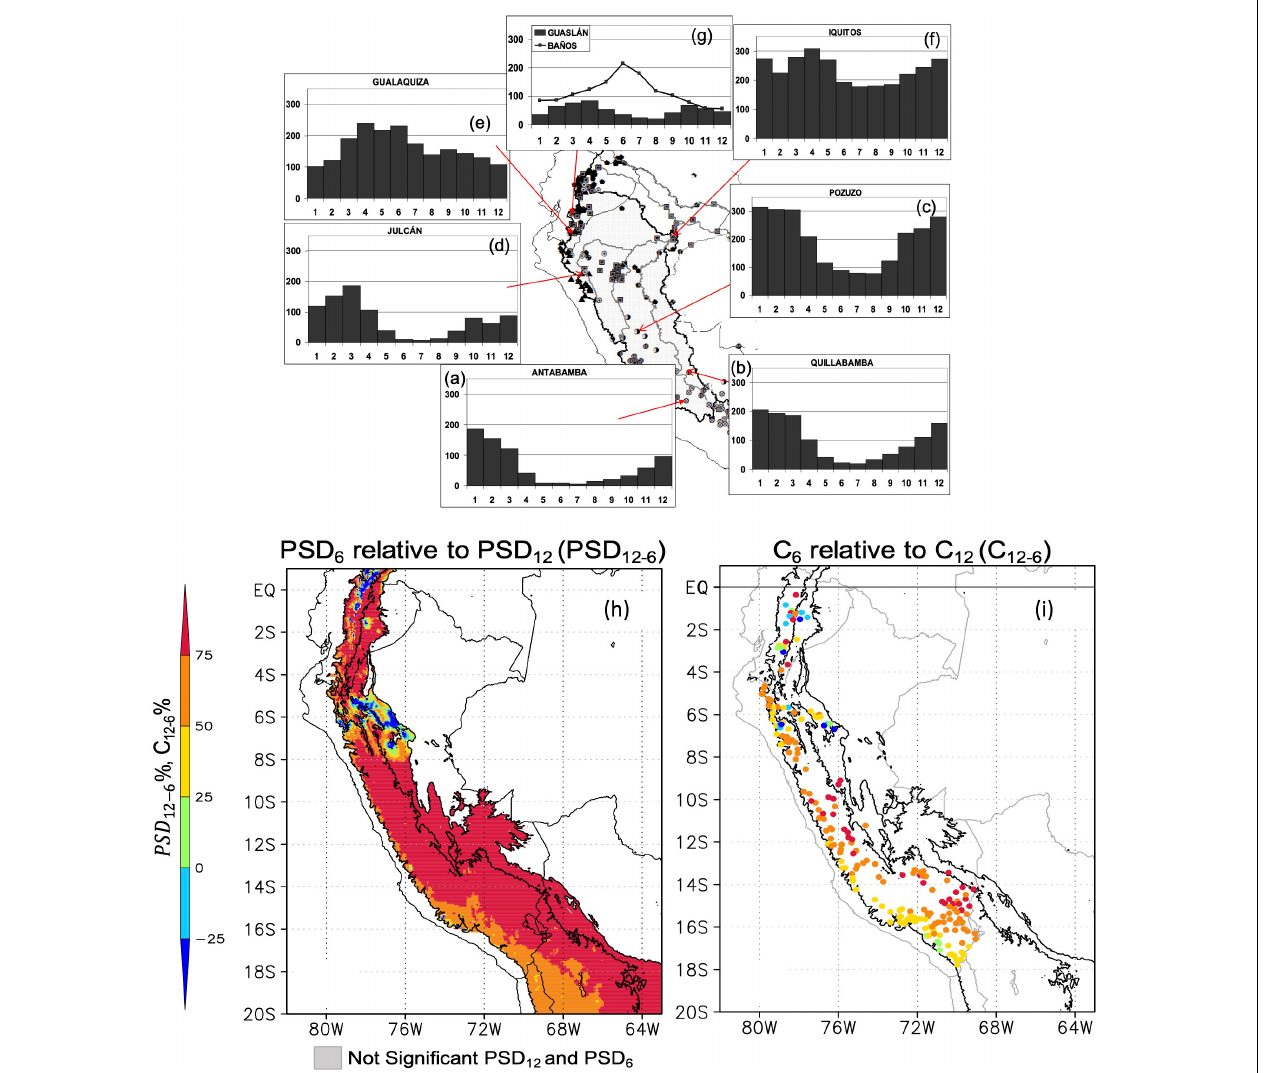
FIGURE 11 | (a–g) Rainfall regimes in eight stations in the south tropical Andes-Amazon region. Adapted from: Espinoza et al. (2009b). © International Journal of Climatology. Reprinted by permission from John Wiley and Sons. (h) Relative difference (PSD12-6; shaded) between the maximum spectral value of monthly precipitation from 10 to 16.67 months (defined as the power spectrum density-PSD12-unimodal index) and the maximum spectral value between 5 and 8 months (defined as the PSD6 bimodal index). PSD12 and PSD6 are computed using Equation 3 in Segura et al. (2019) and CHIRPS data set. (i) Relative difference between the harmonic of 12 months and the harmonic of 6 month (C12-C6) estimated by using in situ precipitation of 206 rain-gauge stations located in Peru and Ecuador and Equation 6 from Segura et al. (2019). Topography contours of the altitude of 350 and 2000 m.a.s.l are plotted in black solid lines. Source: Segura et al. (2019). © Climate Dynamics. Reprinted by permission from Springer